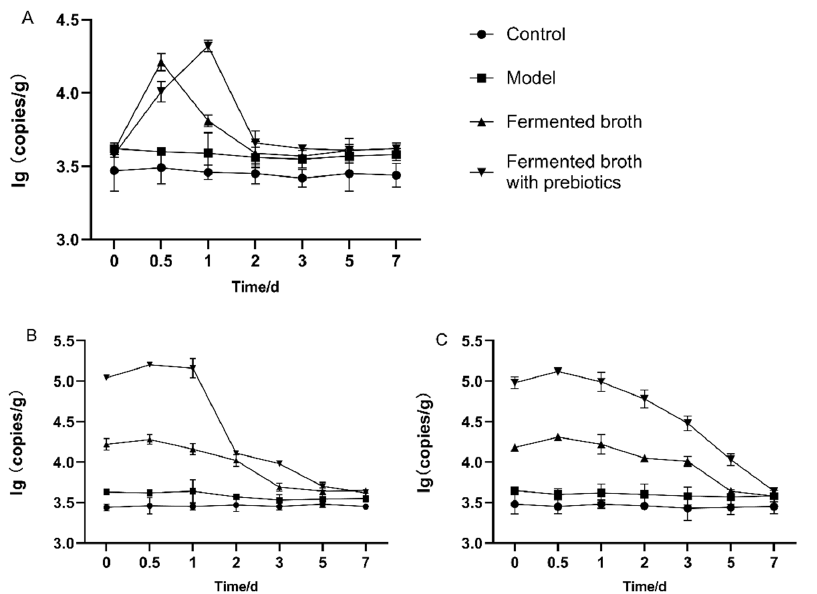
Figure 3. Effect of intragastric administration time on intestinal residence time. ( A ) 1 day; ( B ) 2 weeks; and ( C ) 4 weeks.